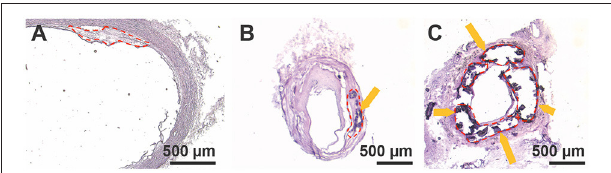
FIGURE 1 | H&E stains of (A) healthy patient aortic tissue (lesion area outlined in red, 0.097 mm 2 ), (B) moderately diseased patient tibial artery (lesion area 0.177 mm 2 ), and (C) severely diseased patient tibial artery (lesion area 0.65 mm 2 ). Dark purple stains and arrows indicate where bulk calcifications in the tissue are